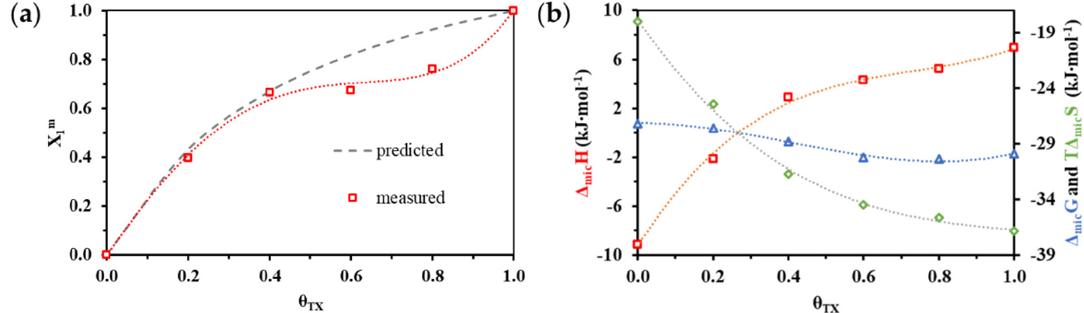
Figure 5. ( a ) Change of experimental ( X 1m values as red squares) and predicted (dashed line calculated by Motomura’s theory [31]) mixed micelle structure as a function of bulk phase composition ( θ TX ) at 298 K ; ( b ) Variation of thermodynamic parameters ( ∆ mic G, ∆ mic H and T ∆ mic S ) determined from enthalpograms of pure ( θ TX = 0.0 and 1.0) and mixed ( θ TX = 0.2; 0.4; 0.6 and 0.8) micelle formation as a function of composition of bulk phase ( θ TX ) at 298 K.